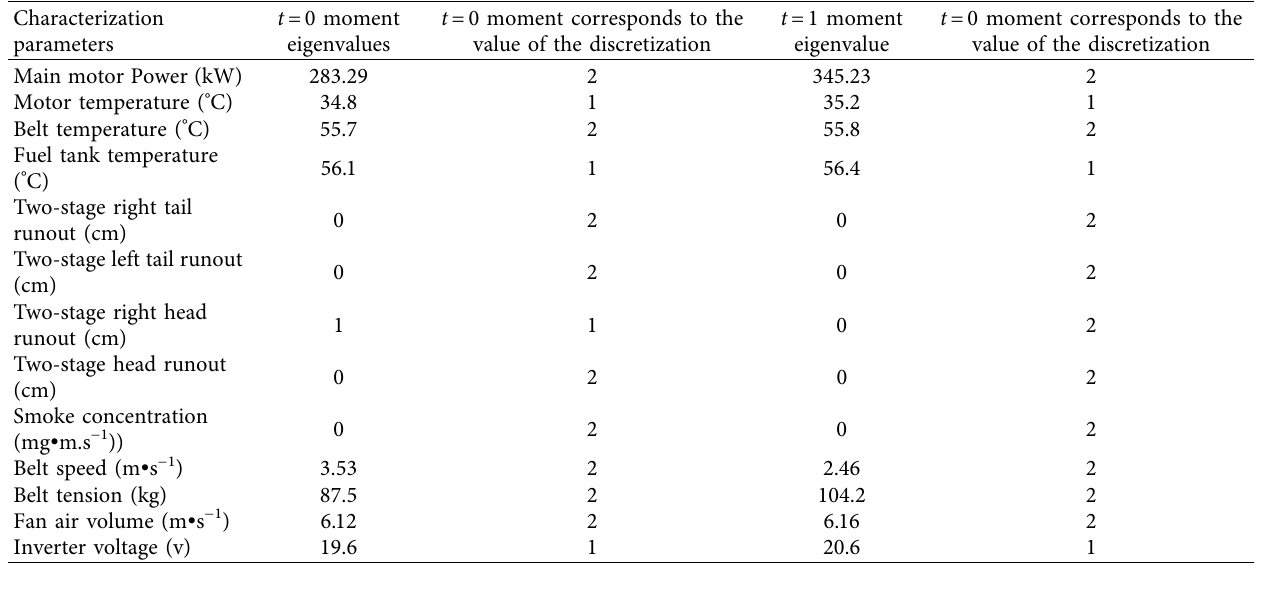
Table 3: Test set 1 node evidence data table.